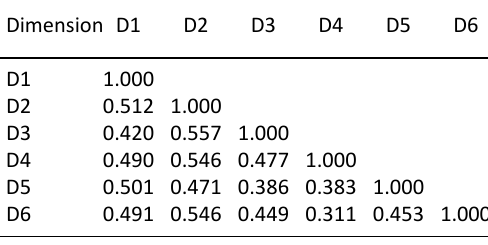
Table 3. Pearson Correlation Coefficient Dimension